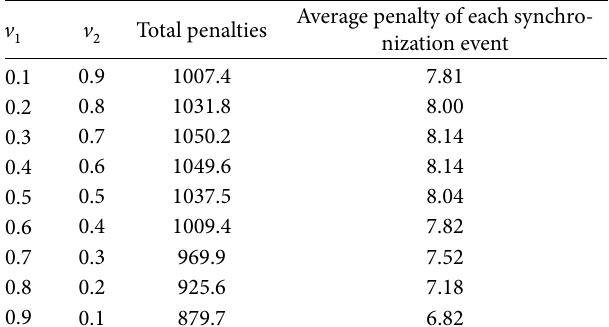
Figure 8: Effects of departure and arrival timetable windows on synchronization when maximizing the coverage of synchronized flights has priority over maximizing the number of